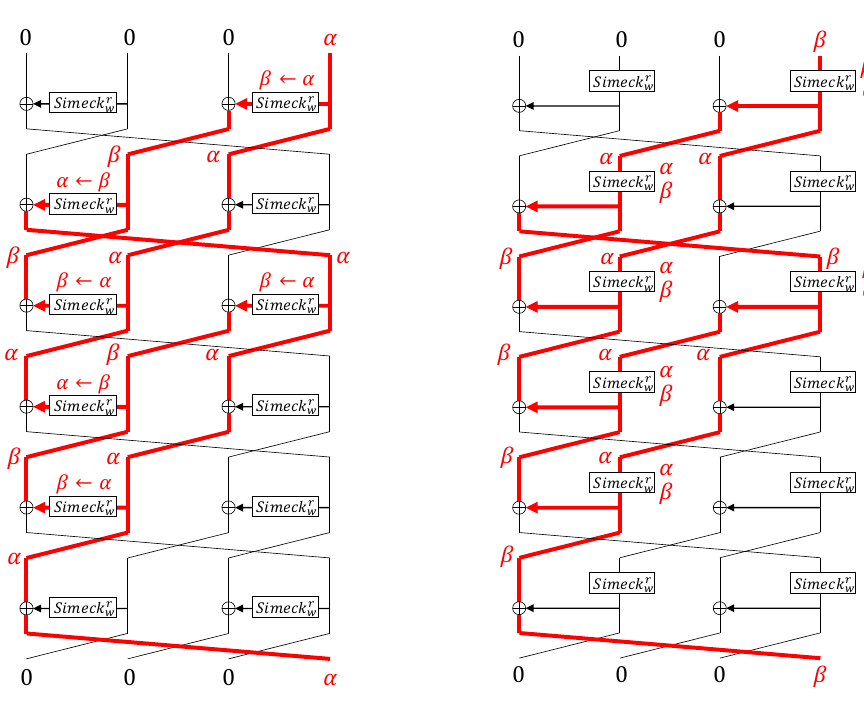
Figure 3: Left: 6-Step Iterative Differential Trail for Original sLiSCP . Right: 6-Step Iterative Differential Trail for sLiSCP-light